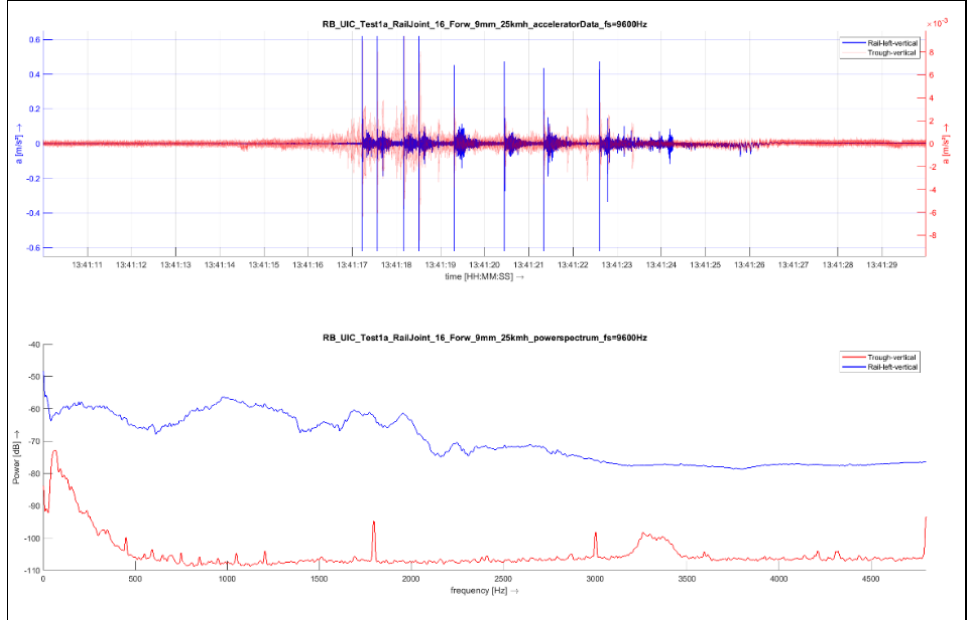
Figure 4 . Acceleration data from a sensor mounted on the rail (blue) and in the trough (red) . Figure 4. Acceleration data from a sensor mounted on the rail (blue) and in the trough